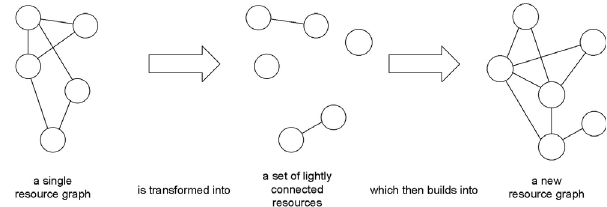
FIG. 9. Wholesale change represented in stages. At a later time, the resource graph describing a situation is entirely different from the original